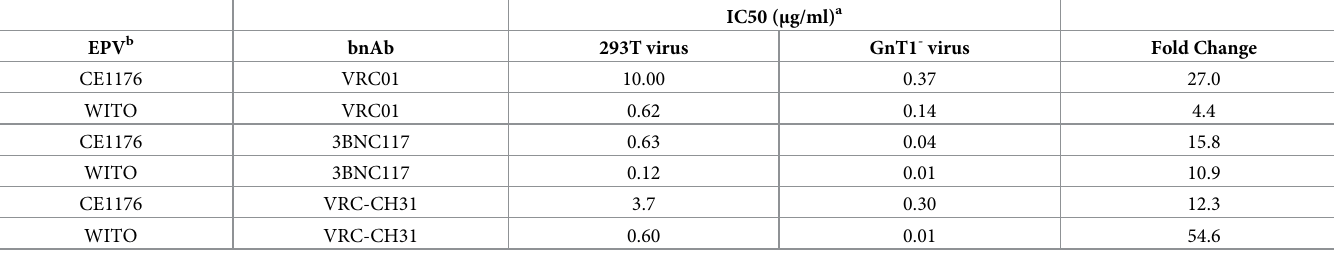
Table 1. GnT1 - production enhances the susceptibility of HIV-1 to neutralization by CD4bs bnAbs.